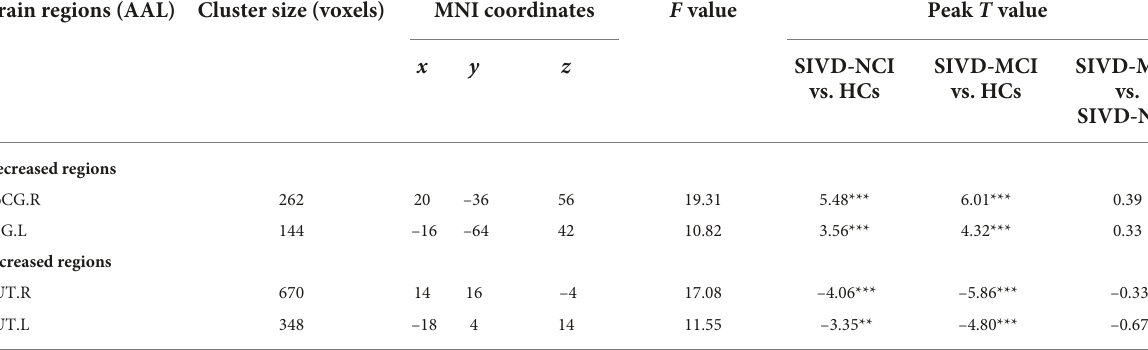
TABLE 3 Brain regions with significant differences in CBF between patients with HCs, SIVD-NCI, and SIVD-MCI. Brain regions (AAL) Cluster size (voxels)